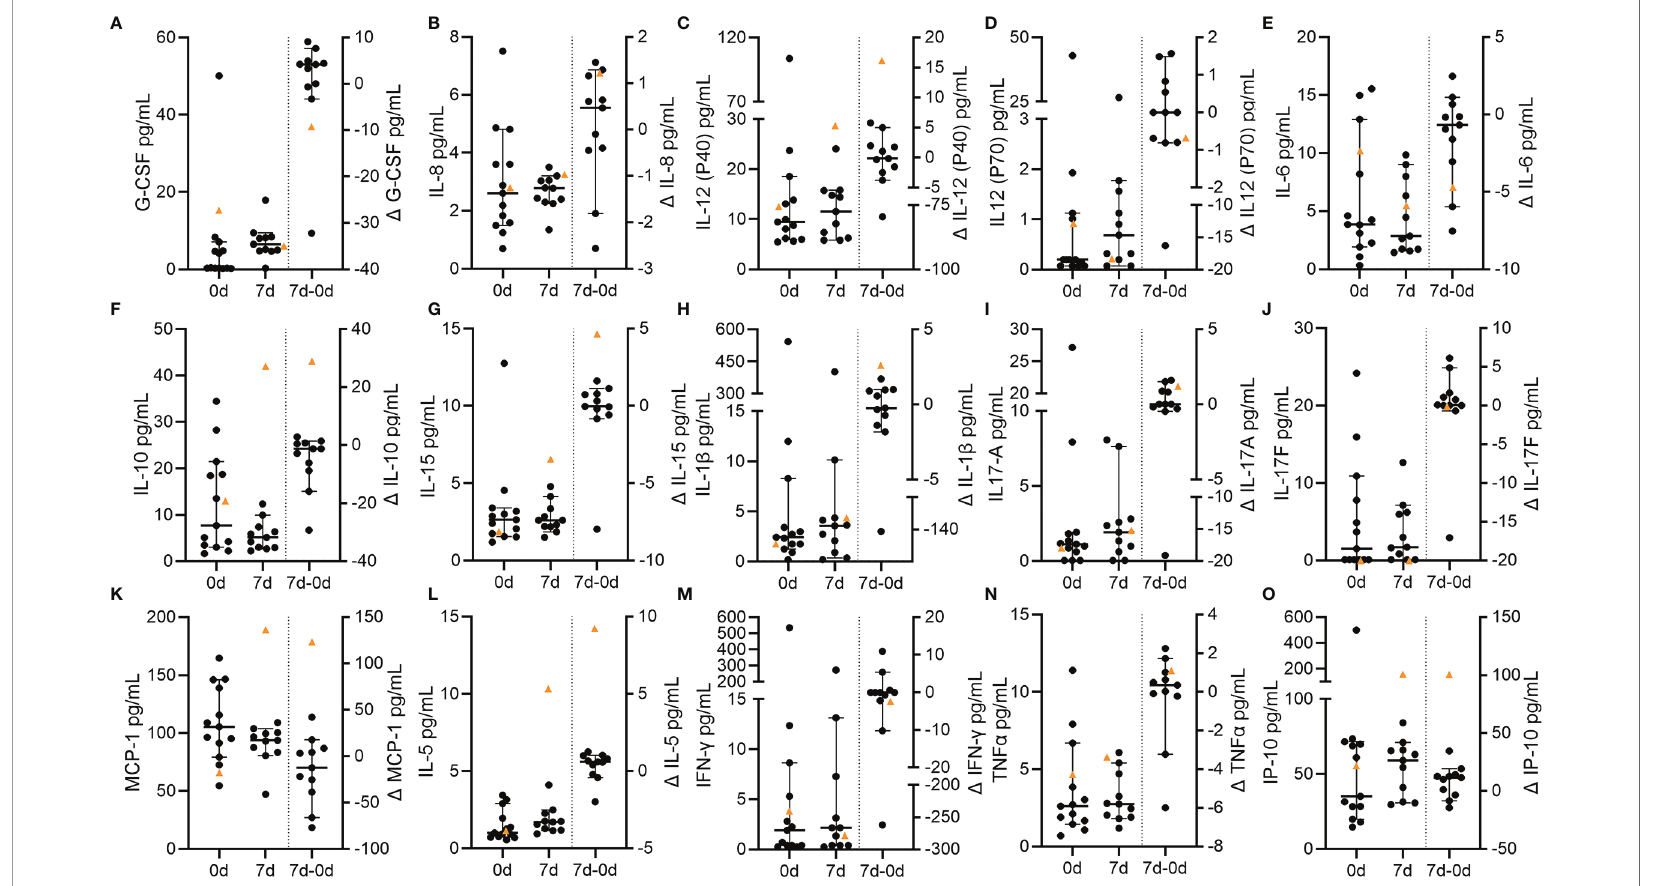
FIGURE 7 | Circulating cytokines in VITT and control stroke patients. Concentrations of circulating cytokines at baseline and at follow-up as well as the temporal differences ( D ) between both time points. Individual data of each patient and the corresponding median and 95% con fi dence intervals of control values are depicted with data points of the VITT-patient highlighted as orange triangle. (A) C-CSF; (B) IL-8; (C) IL-12 (p40); (D) IL-12 (p70); (E) IL-6; (F) IL-10; (G) IL-15; (H) IL-1 b ; (I) IL-17A; (J) IL-17F; (K) MCP-1; (L) IL-5; (M) INF- g ; (N) TNF- a ; (O)